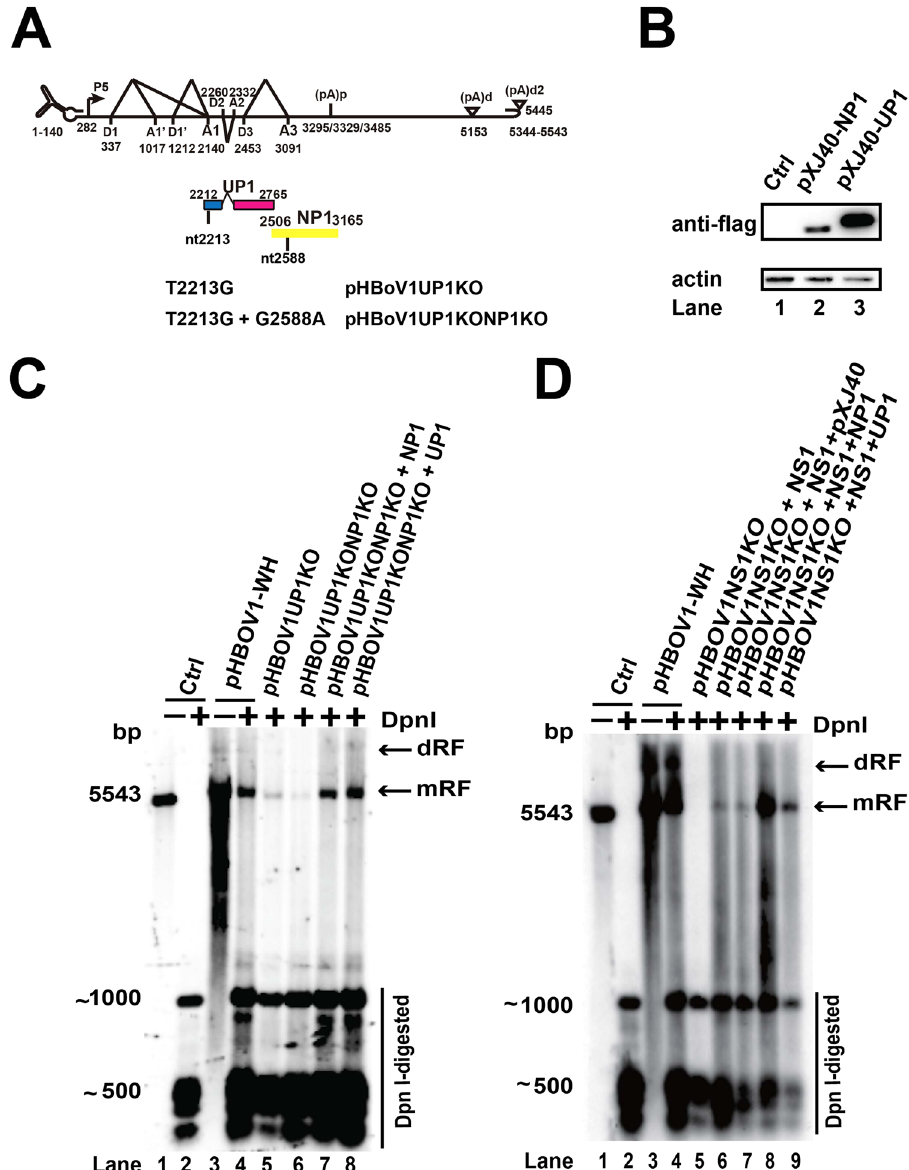
Figure 6. UP1 facilitated HBoV1 viral DNA replication. ( A ) Diagram of UP1 ORF and mutated plasmids. UP1 ORF was disrupted by a single nucleotide mutation. Both UP1 and NP1 ORFs were mutated as indicated. ( B ) Western blot. HEK293T cells were transfected with flag-tagged NP1 and UP1 expression plasmids. The transfected cells were lysed for Western blot analysis with flag and β -actin antibody. ( C and D ) Southern blot analysis. Plasmids in panel A were transfected into HEK293T cells together with UP1 or NP1 expressing plasmids. Hirt DNA was extracted, and Southern blot analysis was performed. The signal was detected by ChemiDoc TM MP imaging